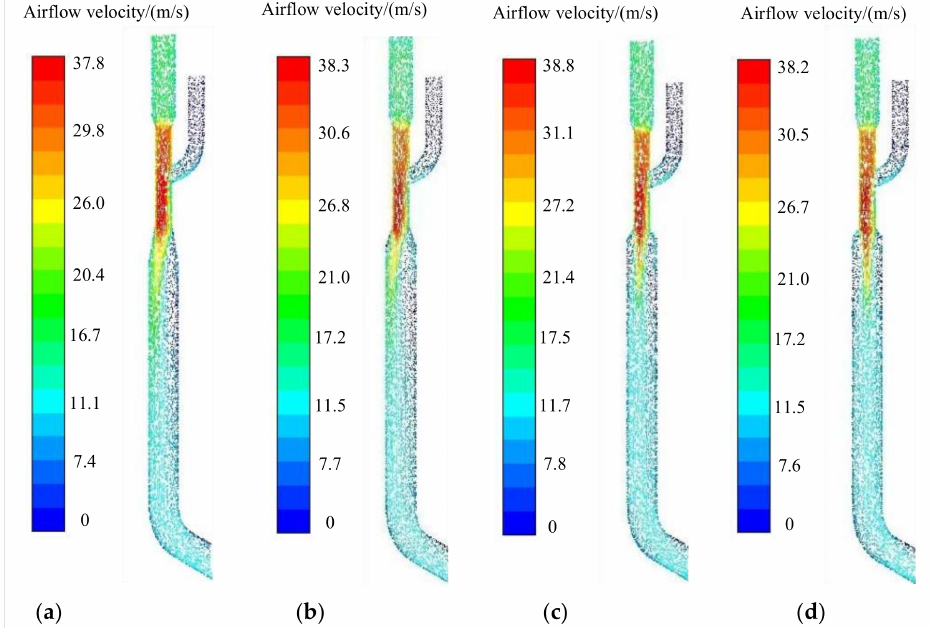
Figure 12. Airflow-velocity contours of different diffusion angles. ( a ) γ 2 = 10 ◦ , ( b ) γ 2 = 20 ◦ , ( c ) γ 2 = 30 ◦ , ( d ) γ 2 = 40 ◦